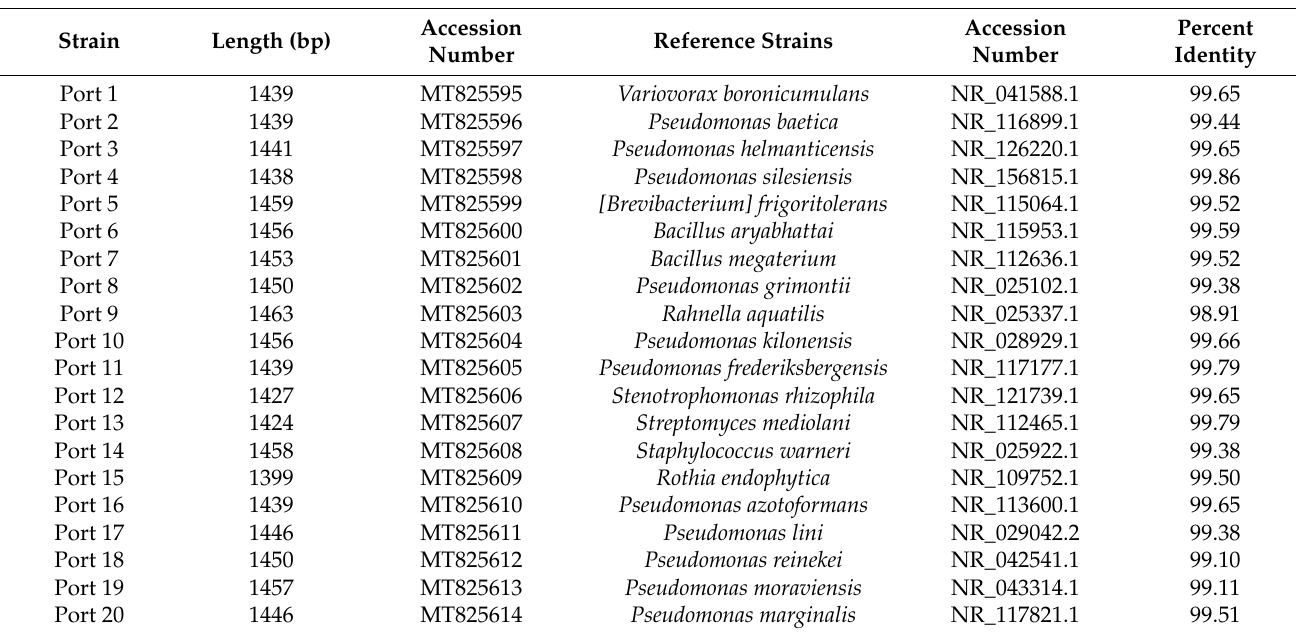
(Figure 4). The bacterial isolates are related to three phyla: Proteobacteria, Actinobacteria, and Firmicutes representing four classes: Gammaproteobacteria (13), Betaproteobacteria (1), Bacilli (4), and Actinobacteria (2). The class Gammaproteobacteria included the or- ders Pseudomonadales, Enterobacterales, and Xanthomonadales. Pseudomonadales was represented by the genus Pseudomonas with 11 strains, and Enterobacterales contained just one strain Rahnella aquatilis Port 9 from Yersiniaceae. Xanthomonadales contained one strain, Stenotrophomonas rhizophila Port 12, and Betaproteobacteria consisted of a single order Burkholderiales with a single strain Variovorax boronicumulans Port 1. The genus Bacillus was represented with one strain [Brevibacterium] frigoritolerans Port 5. The class of Actinobacteria presented bacterial strains of the orders Micrococcales and Streptomycetales, Rothia endophytica Port 15, and Streptomyces mediolani Port